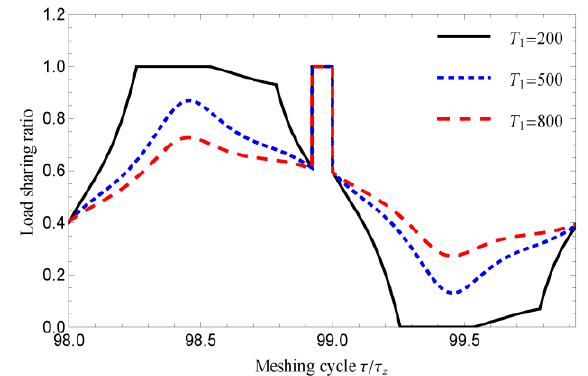
Figure 25. Load sharing ratio of a single pair of teeth under different 𝑇 1 .